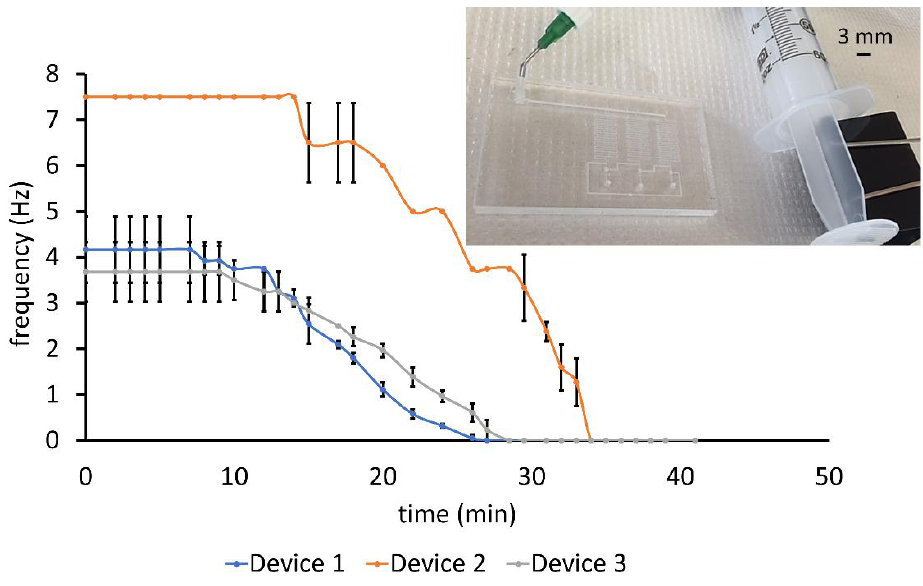
Figure 6. Variation of oscillation frequency with time using a syringe clamped at 47.4 mL level as the supply. Ring oscillator powered by a syringe clamped with a paper clip (inset picture). Error bars denote SD across three trials.